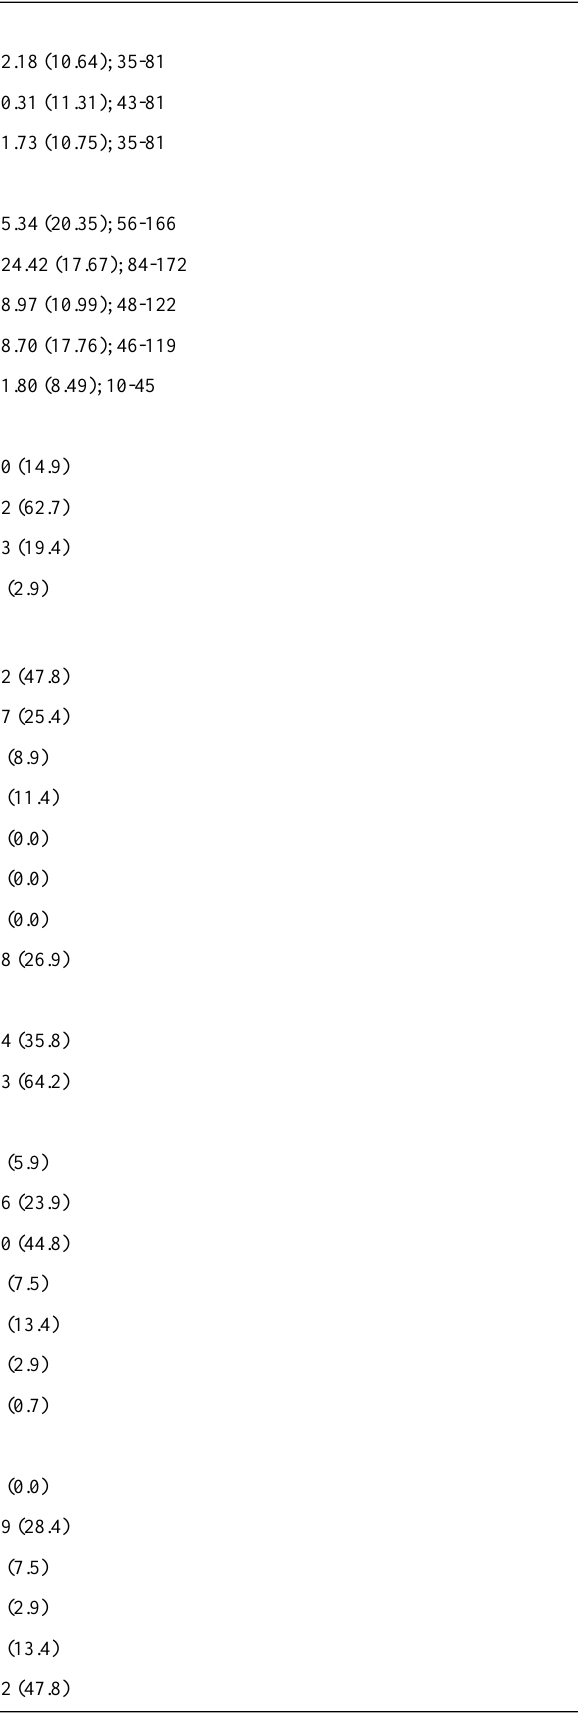
Table 1. Clinical and sociodemographic data of the patients enrolled in the intervention group of the Future Patient Telerehabilitation program (N=67).